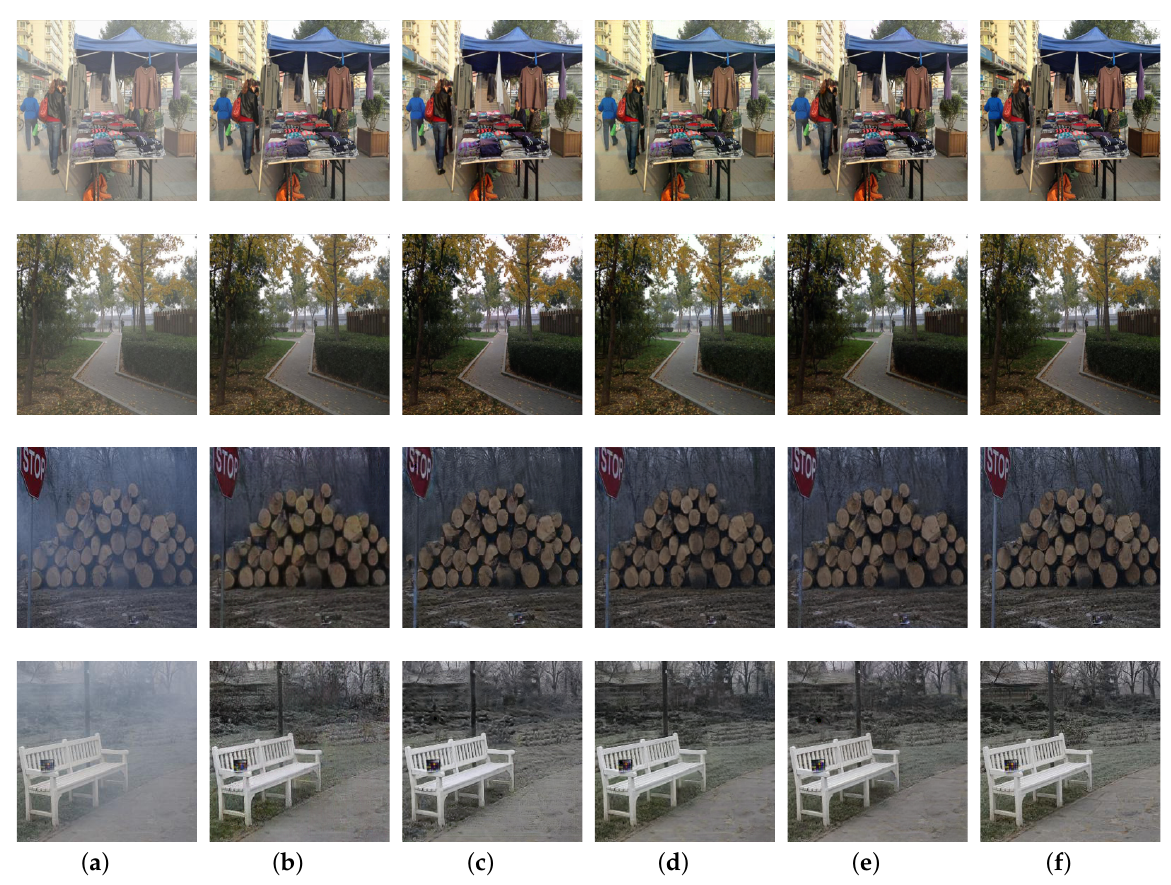
Figure 15. Visual results with different loss functions: ( a ) hazy images; ( b ) without both losses; ( c ) without registration loss; ( d ) without contrastive loss; ( e ) with both losses; ( f ) corresponding haze-free